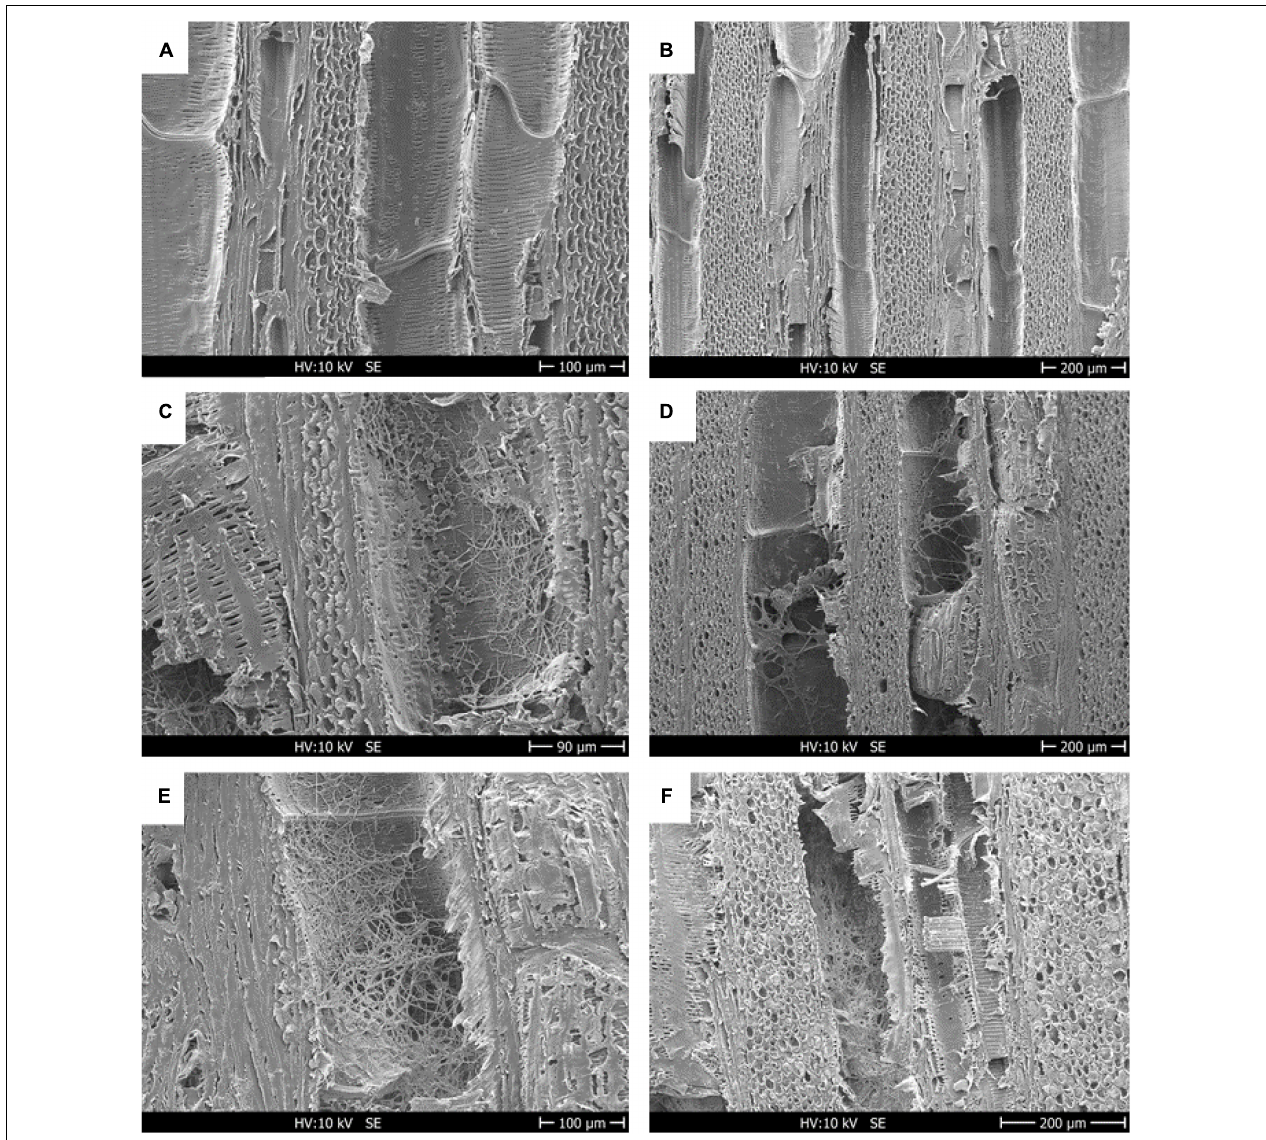
FIGURE 4 | Scanning electron micrographs of cv. Gewurztraminer wood showing the longitudinal face colonized by the white-rot fungus Fmed. Before inoculation by an Fmed-solid culture plug, the wood structures were completely free of mycelium (A,B) ; a diffuse colonization is appreciable after 30 days from inoculum (C,D) , and wider development of the fungus was detected after 90 days (E,F) . After 30 and 90 days, vessels and parenchyma cells were colonized by Fmed hyphae. Scale: (C) = 90 µ m; (A,E) = 100 µ m; (B,D,F) = 200 µ